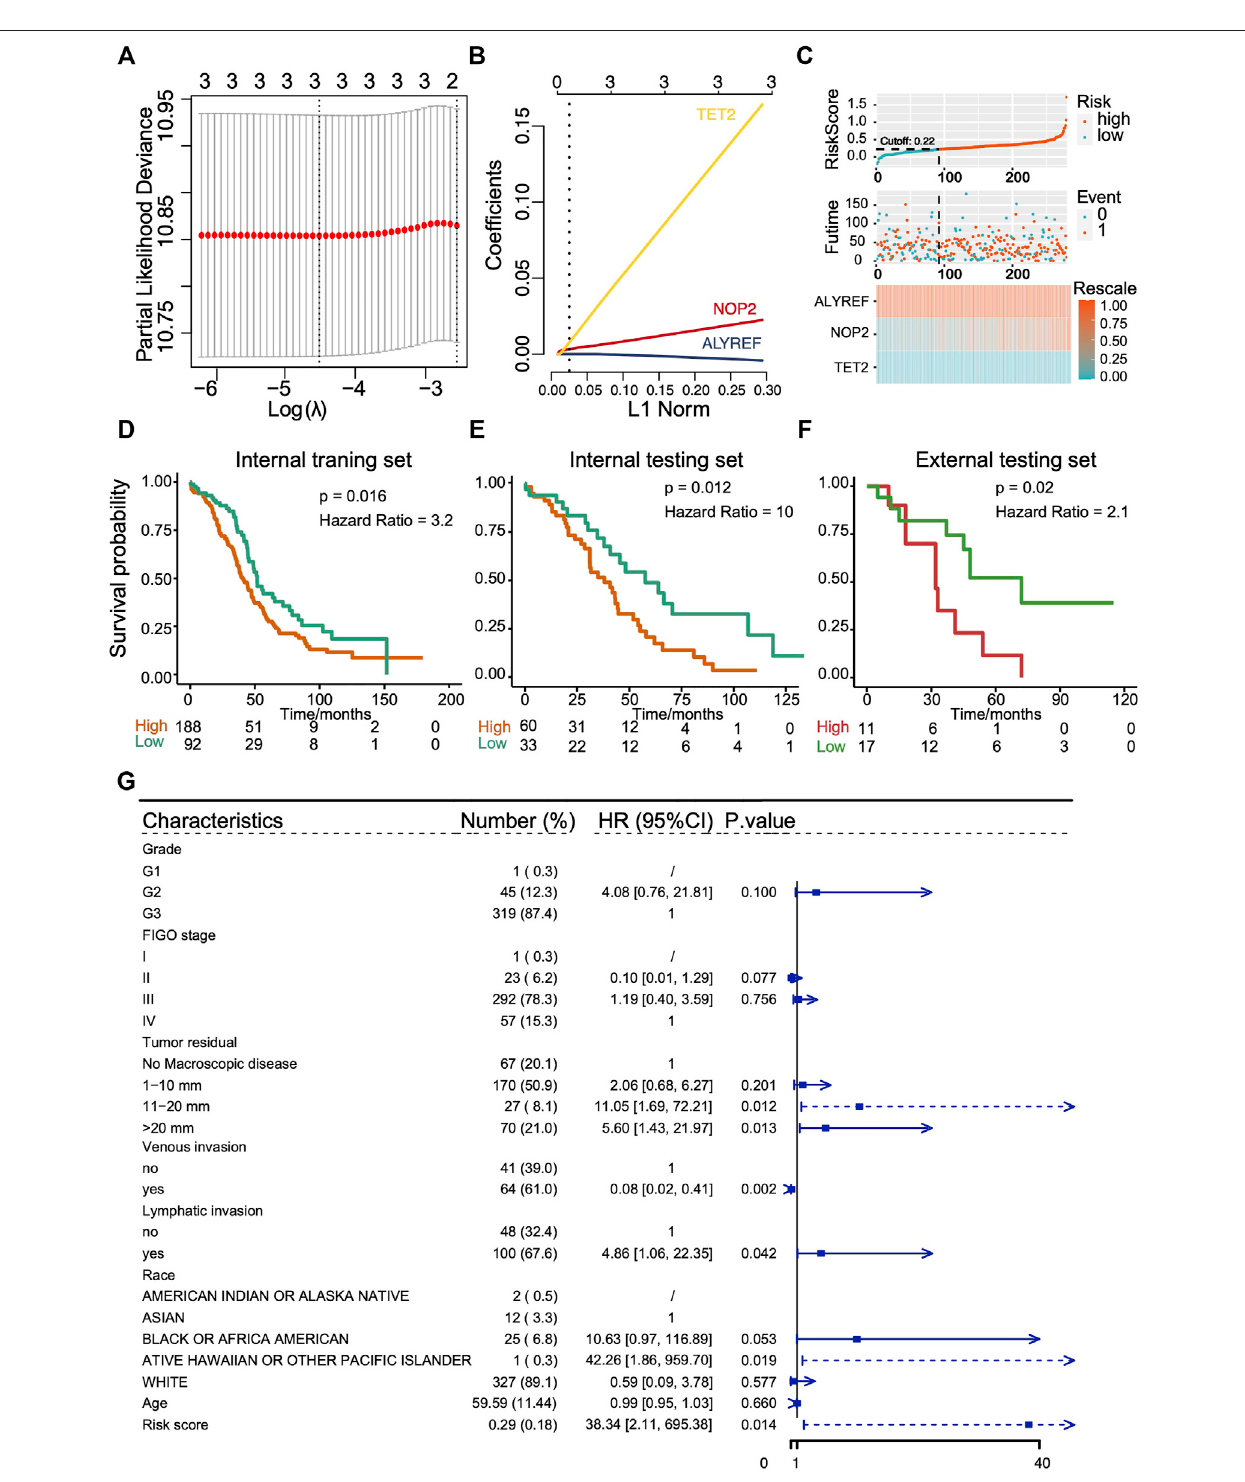
FIGURE 7 | Construction and evaluation of prognostic prediction model with three RNA m 5 C regulators in TCGA cohort and GEO cohort (GSE19829). (A,B) LASSO Cox regression analysis results showing the identi fi cation of three prognostic risk signature genes, and the risk score model is (ALYREF*- 0.00349425170618238) + (NOP2*0.0200758391547147) + (TET2*0.145822477408262). (C) The distribution of prognostic signature-based risk score in internal training set. (D – F) The Kaplan – Meier overall survival analysis for patients with high score and low score in internal training set, internal testing set, and external testing set. (G) The m 5 C risk score in Cox multivariate analysis for OS of ovarian cancer patients.